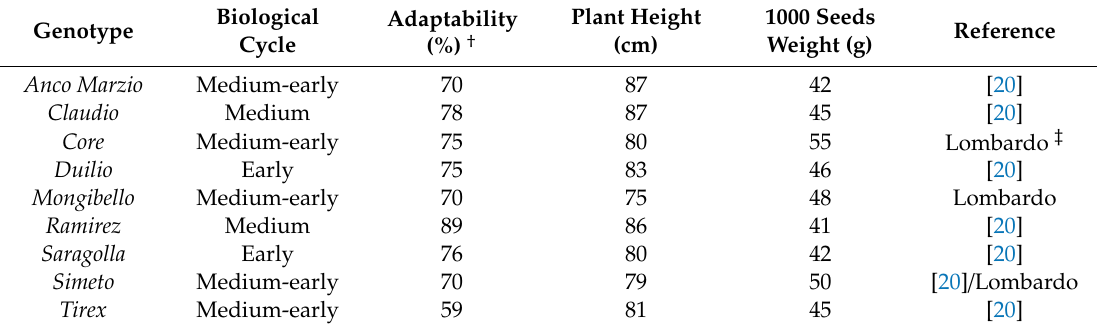
Table 1. Main agronomic characteristics of the nine durum wheat genotypes under